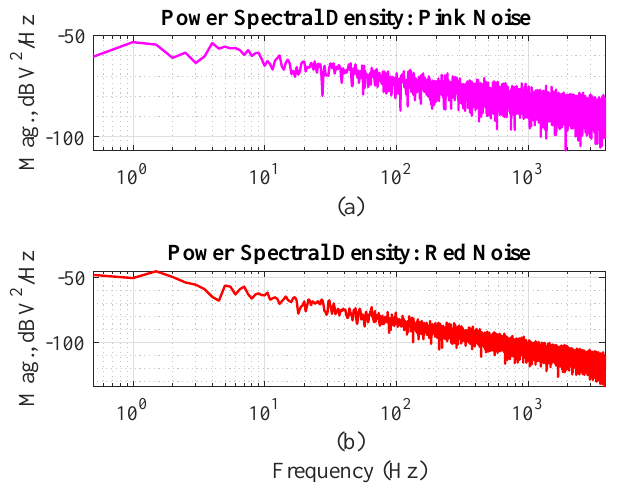
Figure 5. Power spectral density with of the additive ( a ) pink noise and ( b ) red noise of SNR = 5 dB.